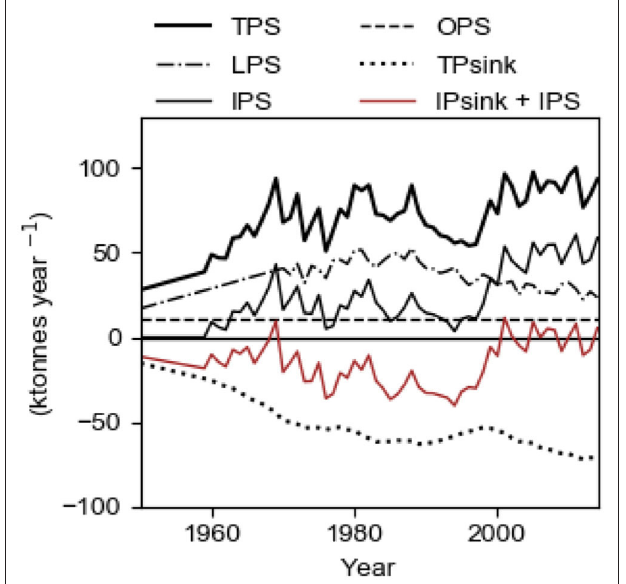
FIGURE 9 | Sources and sinks in the Baltic proper in the period 1950–2014. Computational results from the model with fs = 1.22 tons km − 2 year − 1 and TRVF = 3,000 km 3 year − 1 . LPS , OPS , and Aanox are input data. TPS equals LPS + OPS + IPS and TPsink = IPsink + EPsink and EPsink ≈ 0.24 · TPsink . The curve IPsink + OPS shows the net growth (negative values in the graph) of the internal storage of P.